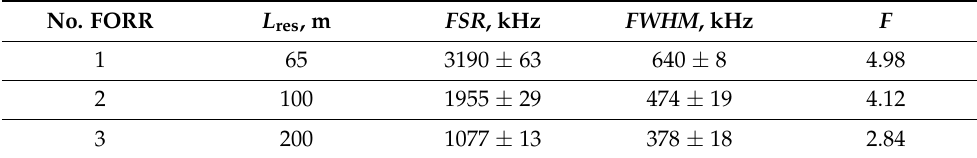
Table 2. Parameters of the FORR on a single-mode fiber.